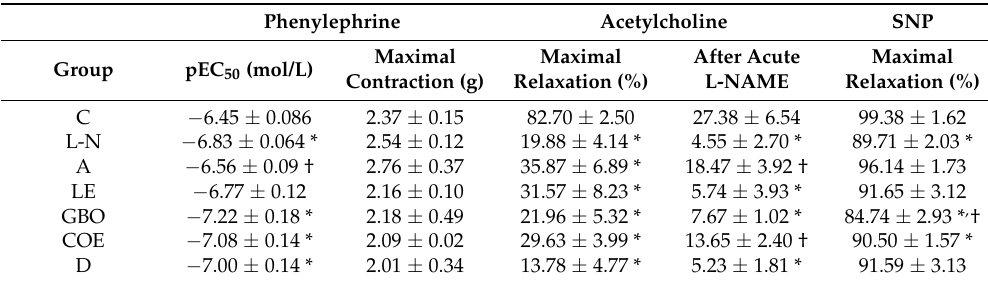
Table 2. Contractile response to phenylephrine and maximal relaxation to acetylcholine and sodium nitroprussside in the experimental groups.